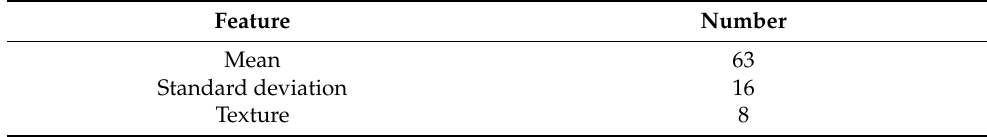
Table 4. Summary of feature types for object/pixel-based